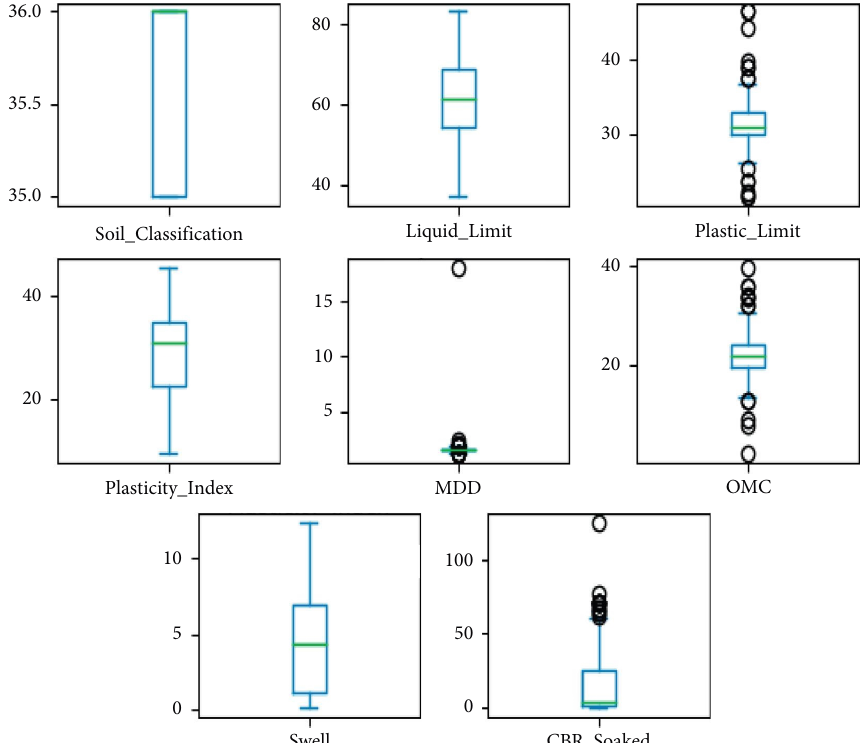
Figure 3: Te distribution of the dataset using a box